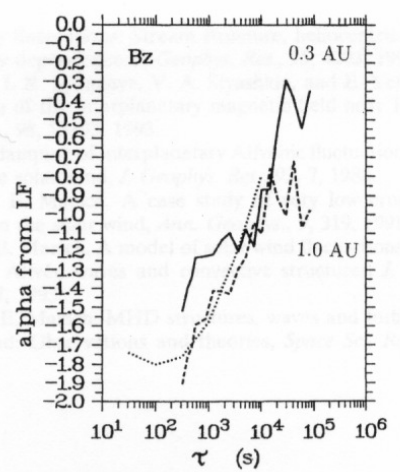
Figure 56: Spectral exponents for the 𝐵 𝑧 component estimated from the length function computed from Helios and Ulysses magnetic field data. Ulysses length function (dotted line) is the same shown in the paper by Horbury et al. (1995a) when the s/c was at about 4 AU and ∼ − 50 ∘ latitude. Image reproduced by permission from Marsch and Tu (1996), copyright by